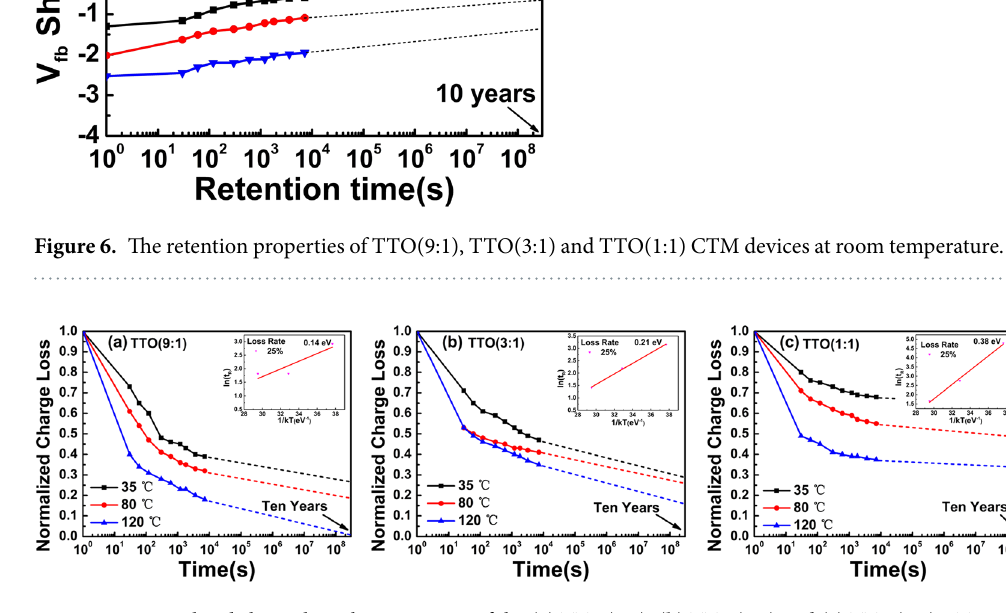
Figure 7. Normalized charge loss characteristics of the ( a ) TTO(9:1), ( b ) TTO(3:1) and ( c ) TTO(1:1) CTM devices at 35, 80, 120 °C. The insets are Arrhenius plots of retention time and reciprocal